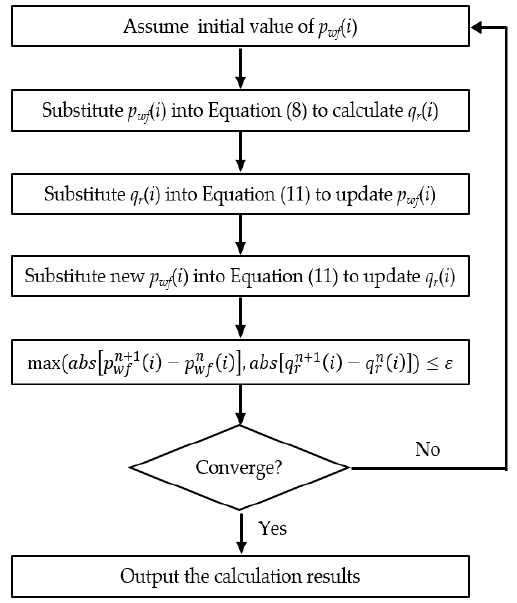
Figure 4. The flow chart of solution procedure.